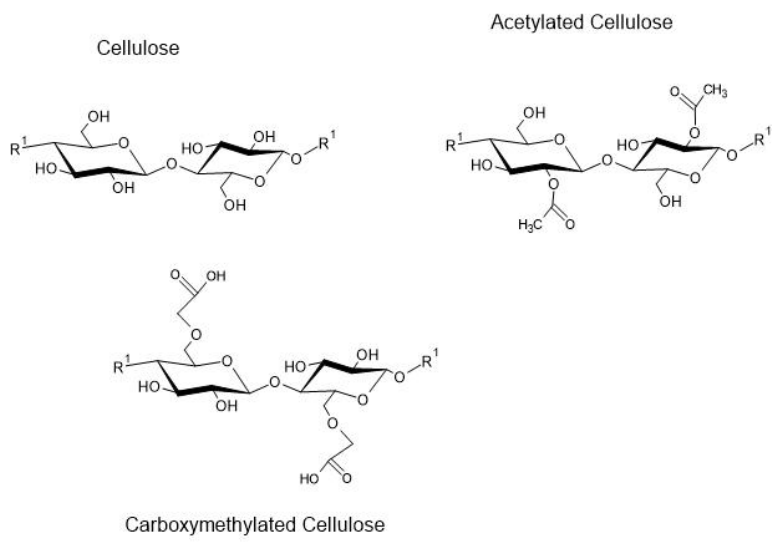
Figure 6. Representation of modified cellulose.